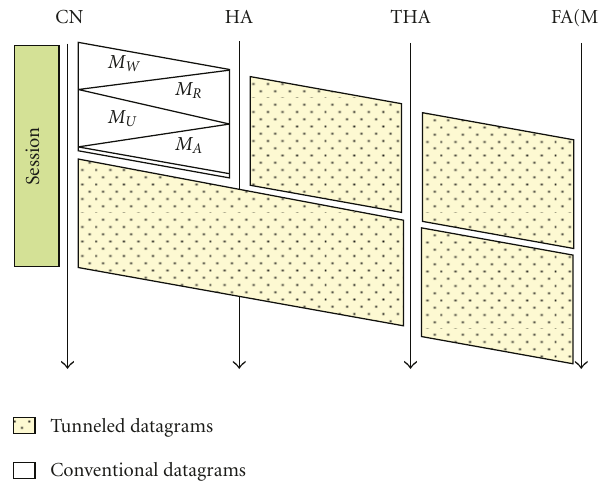
Figure 1: Flow diagram for data delivery in HH-MIP.